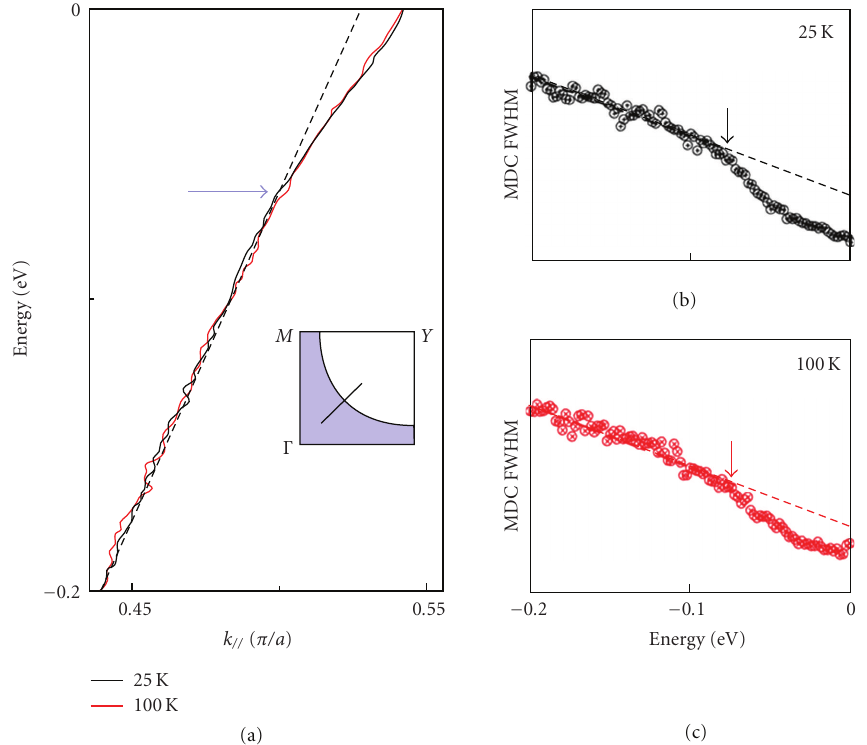
Figure 3: ARPES MDC dispersion data taken optimally doped Bi 2 Sr 2 CaCu 2 O 8+ δ ( T c = 92K) as discussed in [16]. Nodal point data (see inset) comparing (a) dispersion and (b-c) MDC full width half max (FWHM) showing little change in the energy of the ARPES kink with T c . The MDC FWHM is related to the Im Σ ( k , ω